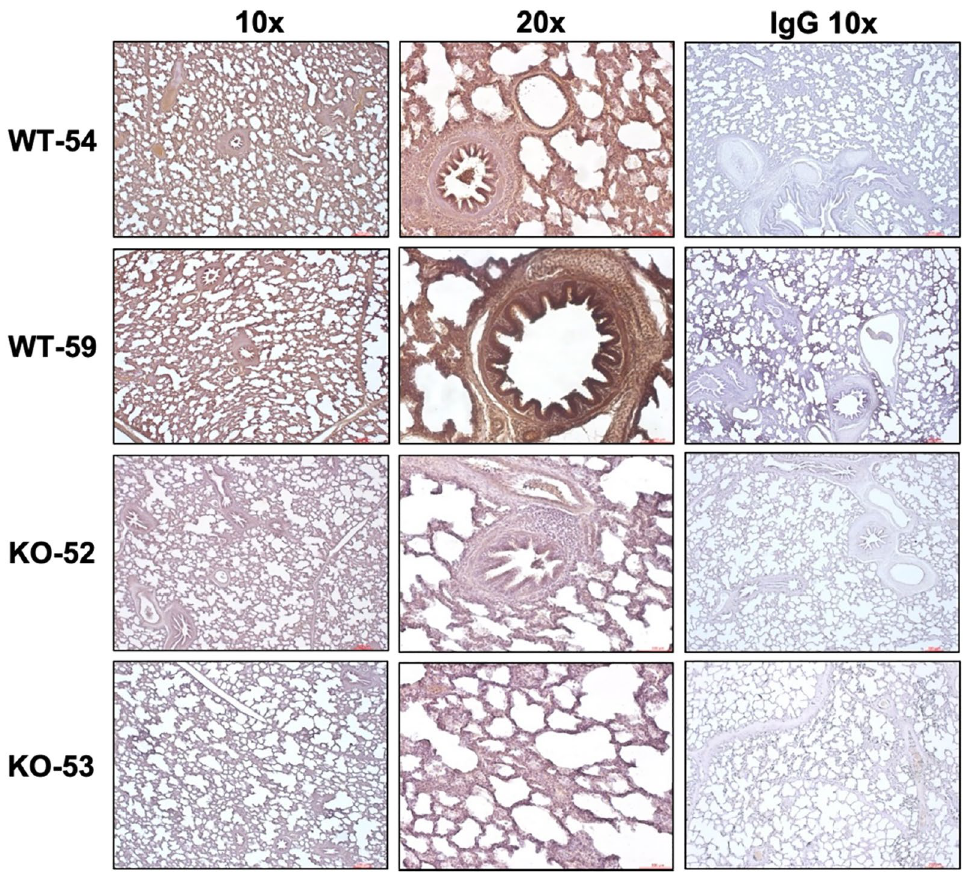
Figure 4. ANTXR1 detection in lung tissue from WT and KO pigs after the SVA challenge. Immunohistochemistry for ANTXR1 in lung sections for WT (54 and 59) and KO (52 and 53) at 10 × and 20 ×. Negative control sections incubated with rabbit IgG are shown to the right. Scale bars are 200 μm for 10 × and 100 μm for 20